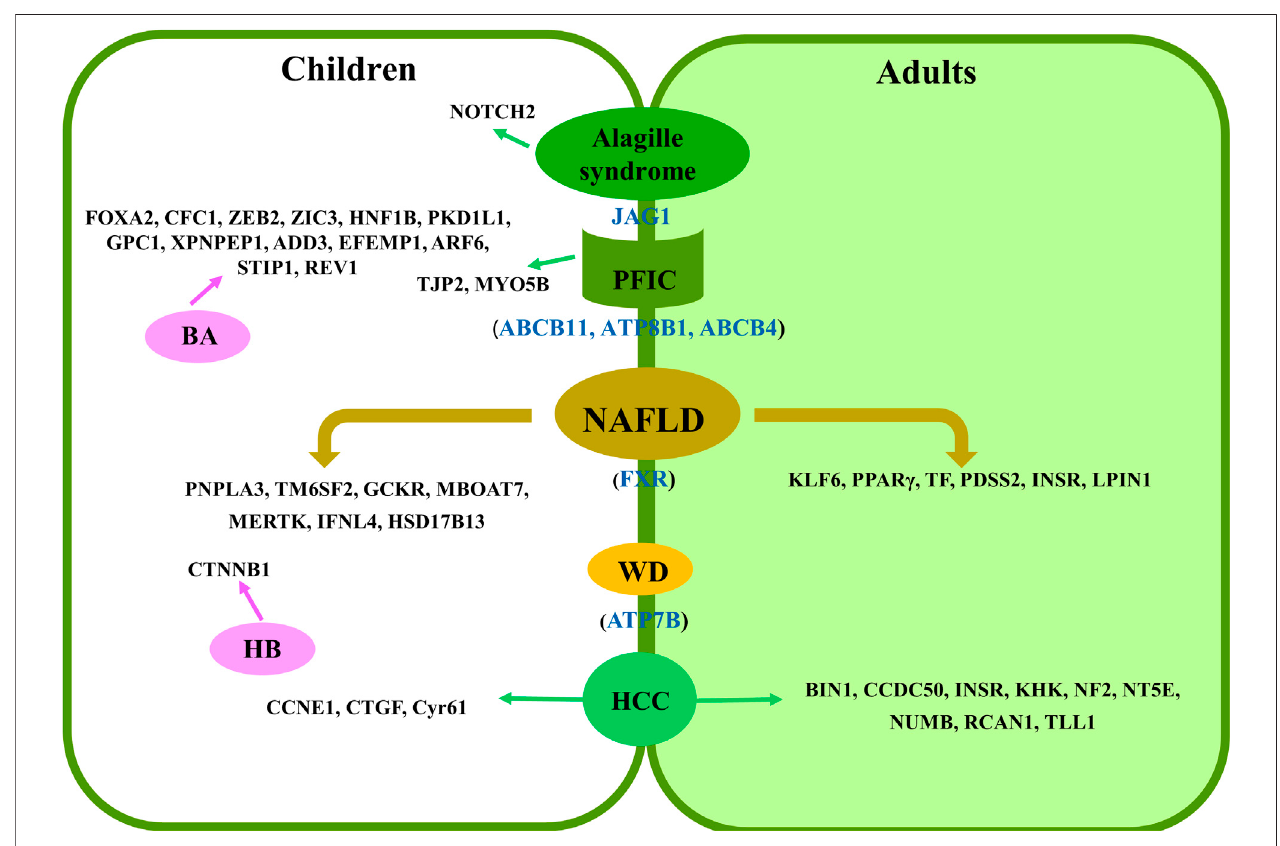
FIGURE1| Summary ofsplicing-related loci inpediatric liverdiseases.Shared loci byadultsand children arepresented asbluein colorinbrackets. Speci fi clocito children or adults are presented in the left and right panels, respectively.